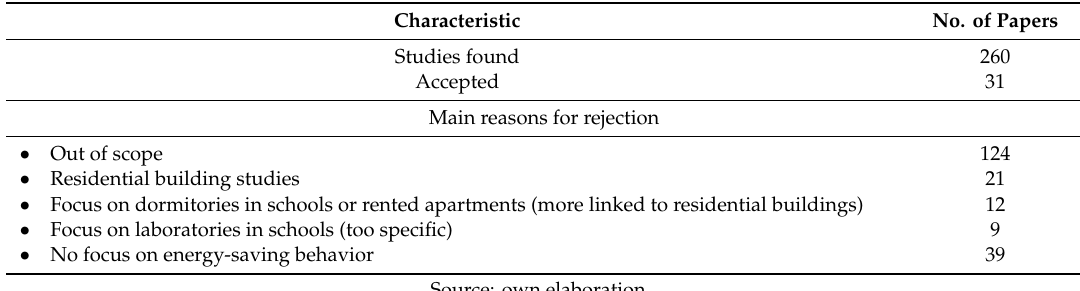
Table 1. Summary of the selection